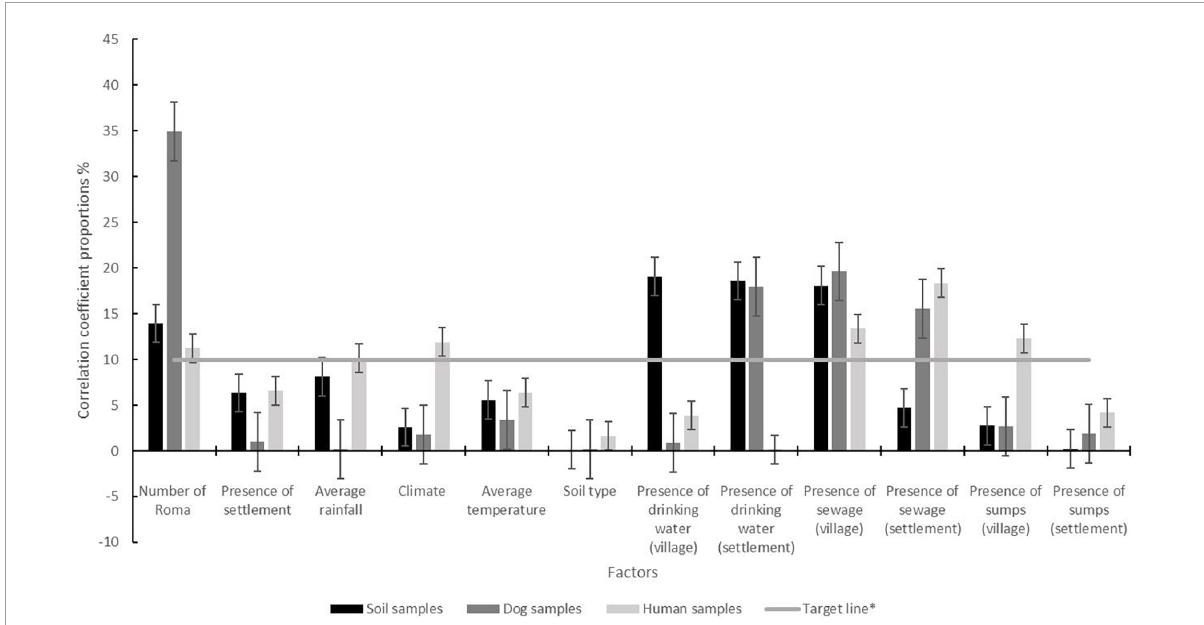
FIGURE3 Comparison of correlation coefficients for each factor in percentage in surveyed sample types. Error bars represent standard error. ∗ -Threshold value of 10% of the proportion of the correlation coefficient.